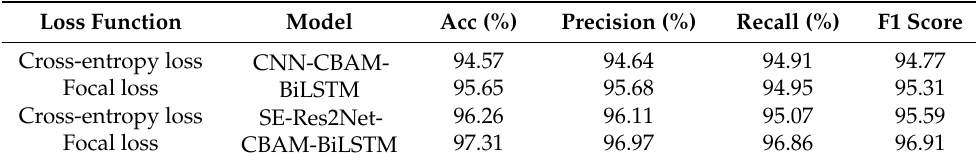
Table 6. Graph of language identification results with different loss